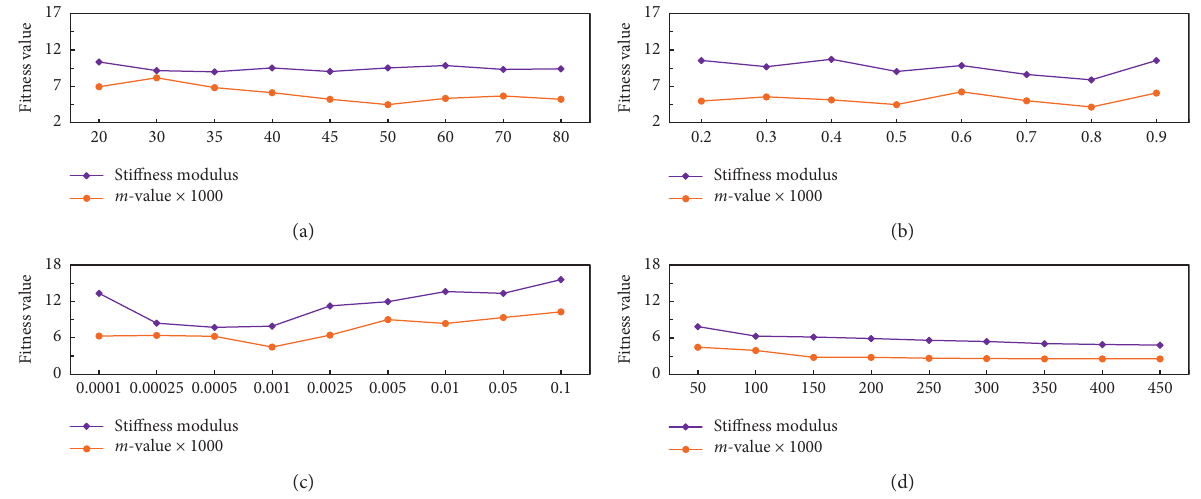
Figure 3: The parameter optimization results of the GA. (a) Population size. (b) Crossover probability. (c) Mutation probability. (d) Maximum iterations.